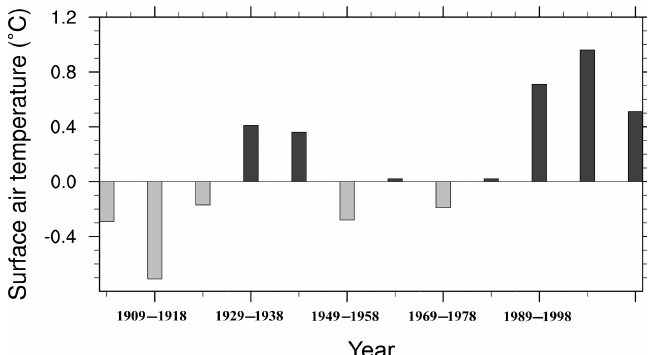
Figure 7. Averaged annual mean SAT anomalies for each decade ( ◦ C) in Qingdao during 1899–2014 relative to the 1961–1990 reference period (black line in Fig. 6; gray bar means negative values and black bar means positive values).